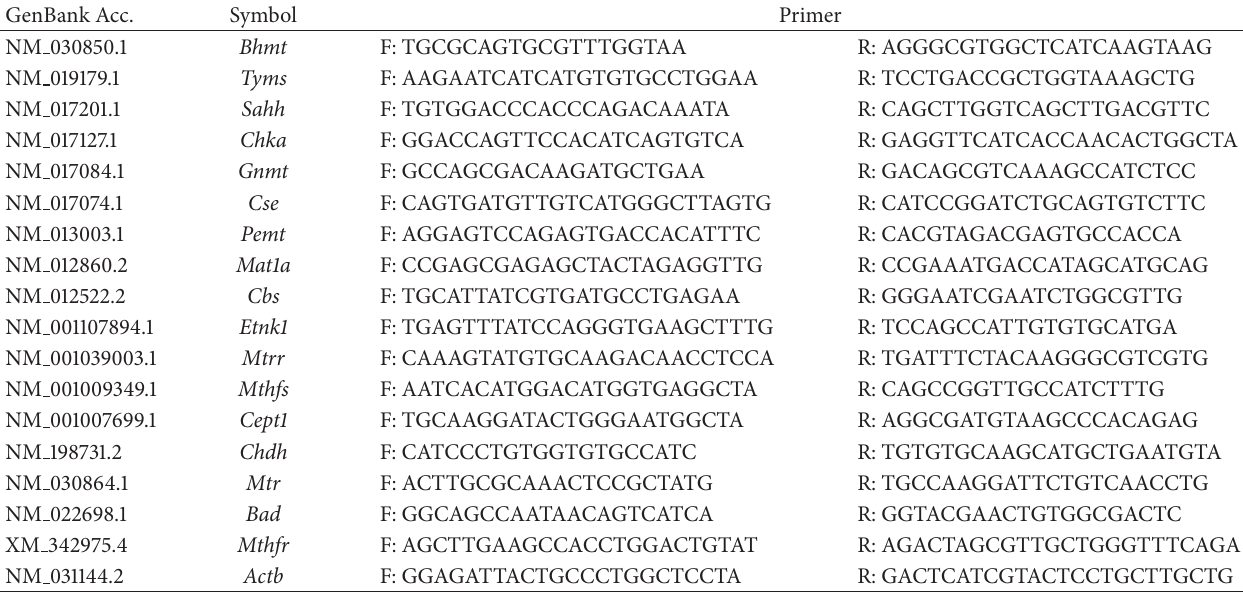
Table 1: The primers used in real time PCR.